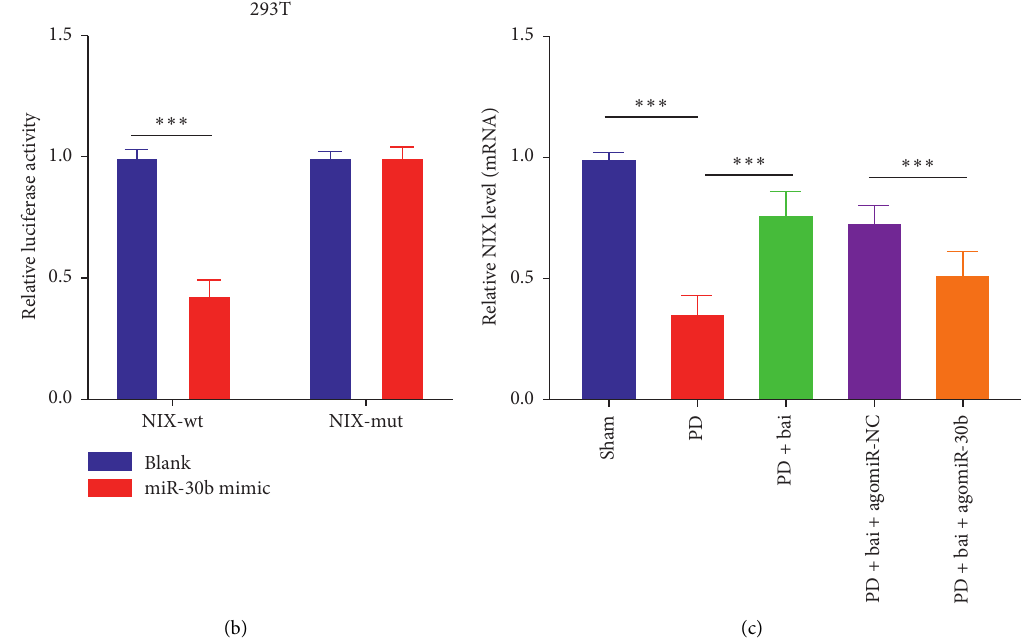
Figure 4: miR-30b targeted NIX. (a) The binding sites between miR-30b and NIX were predicted by TargetScan website. (b) The target binding relationship between miR-30b and NIX was verified by dual-luciferase assay. (c) The expression of NIX was detected by RT-qPCR. Three independent repeated cell tests were performed. N � 6. The data in the figure are all measurement data and the data are expressed as mean ± standard deviation; two-way ANOVA (Figure (b)) and one-way ANOVA (Figure (c)) were used for variance analysis; Tukey’s multiple comparisons test was used for post hoc test. ∗∗∗ P < 0 .